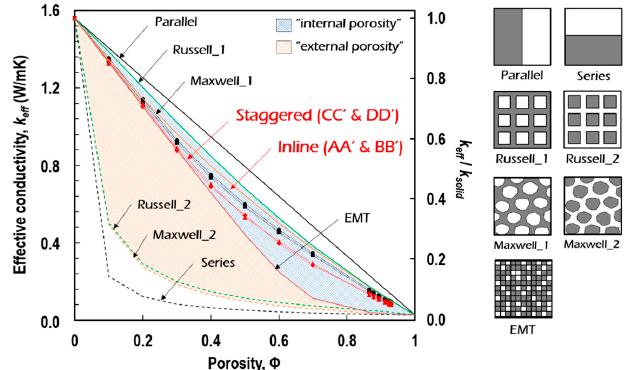
Figure 13. Φ - k eff relationships obtained from FEA multicellular simulations with existing generic models.